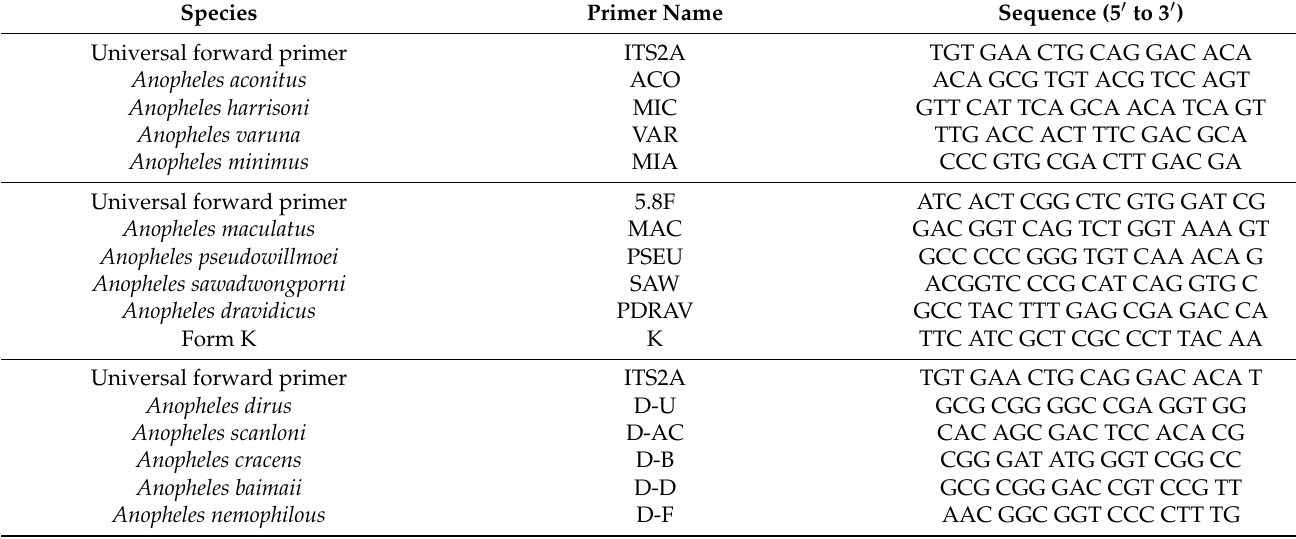
Table 1. Primers and sequences used for molecular identification of Anopheles mosquito species.